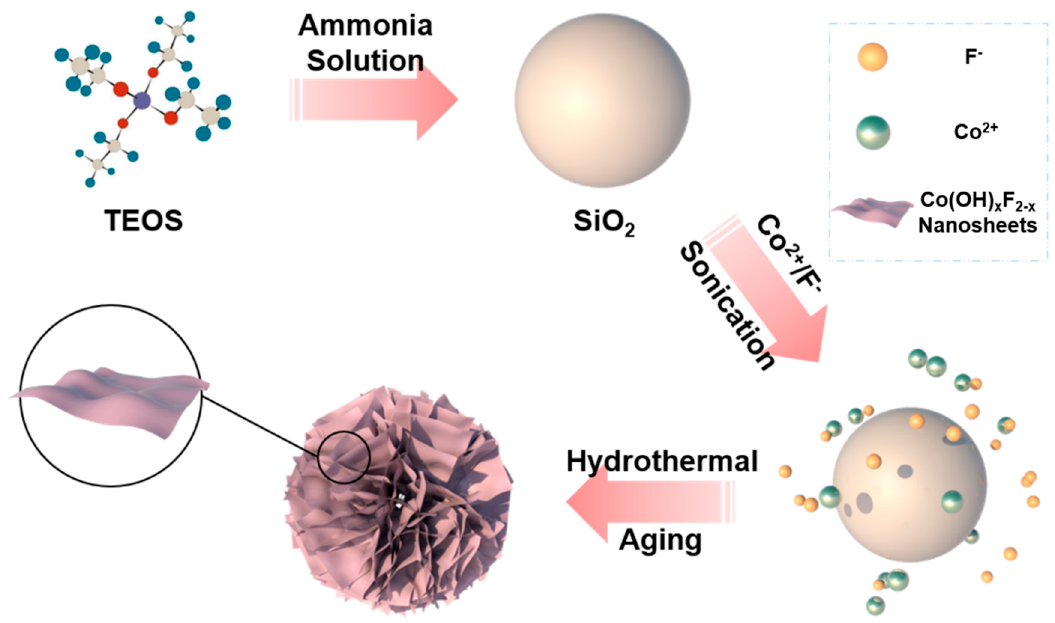
Figure 1. Illustration of the synthesis process of Co(OH) x F 2 − x nanosheets.